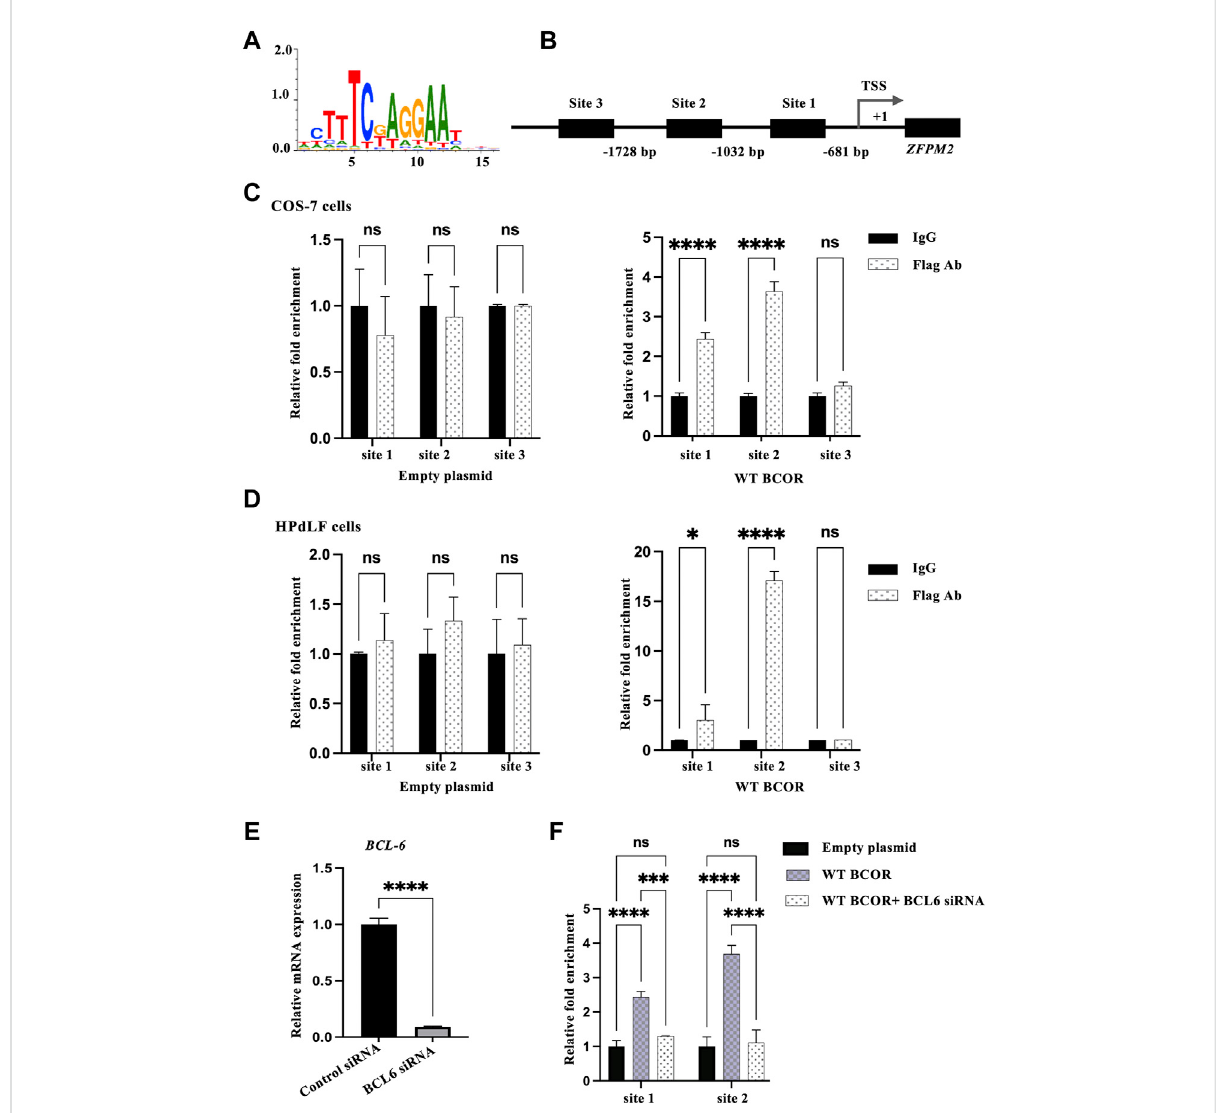
FIGURE 2 Identifying BCOR downstream genes. (A) BCL6 consensus logo. (B) Prediction of BCL6 binding sites in the ZFPM2 promoter region. Three BCL6bindingsiteswithin2 kbofexon1ofZFPM2wereidenti fi edusingLASAGNA-Search2.0.TSSrepresentstranscriptionstartsite. (C,D) ChIPassay for the occupation of BCL6 on the promoter of ZFPM2 in COS-7 and HPdLF cells. IgG, n = 3; empty plasmid/WT BCOR, n = 3. Data are expressed as the means ± standard deviations from triplicate experiments. ANOVA was used to assess differences in fold change within each group. * p < 0.05, **** p < 0.0001; ns, not signi fi cant. (E) Validation of BCL6 suppression in COS-7 cells using qRT-PCR. t -test, **** p < 0.0001. (F) BCL6 knockdown co-transfected with WT BCOR failed to recruit promoter binding sitesinCOS-7 cells. Data are expressedas themeans±